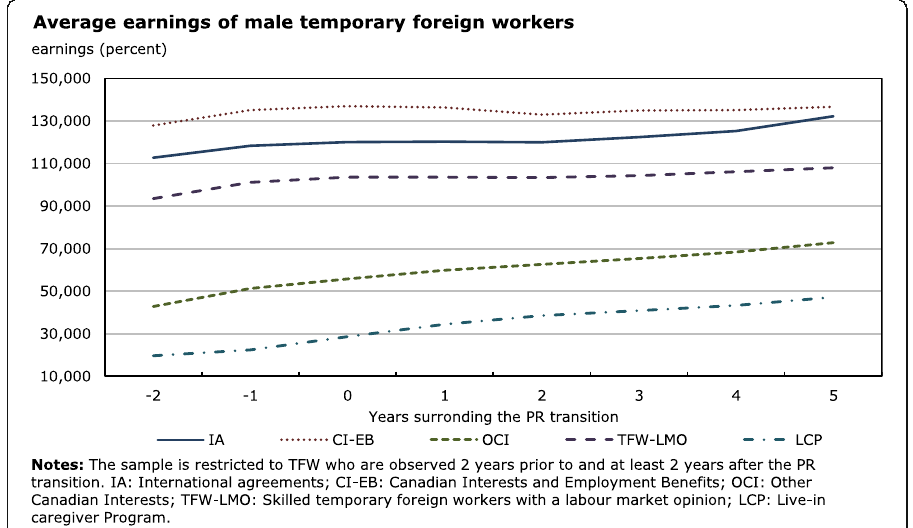
Fig. 3 Average earnings of male temporary foreign workers. Sources: Statistics Canada, Temporary Residents file, Immigrant Landing file and Canadian Employer-Employee Dynamics